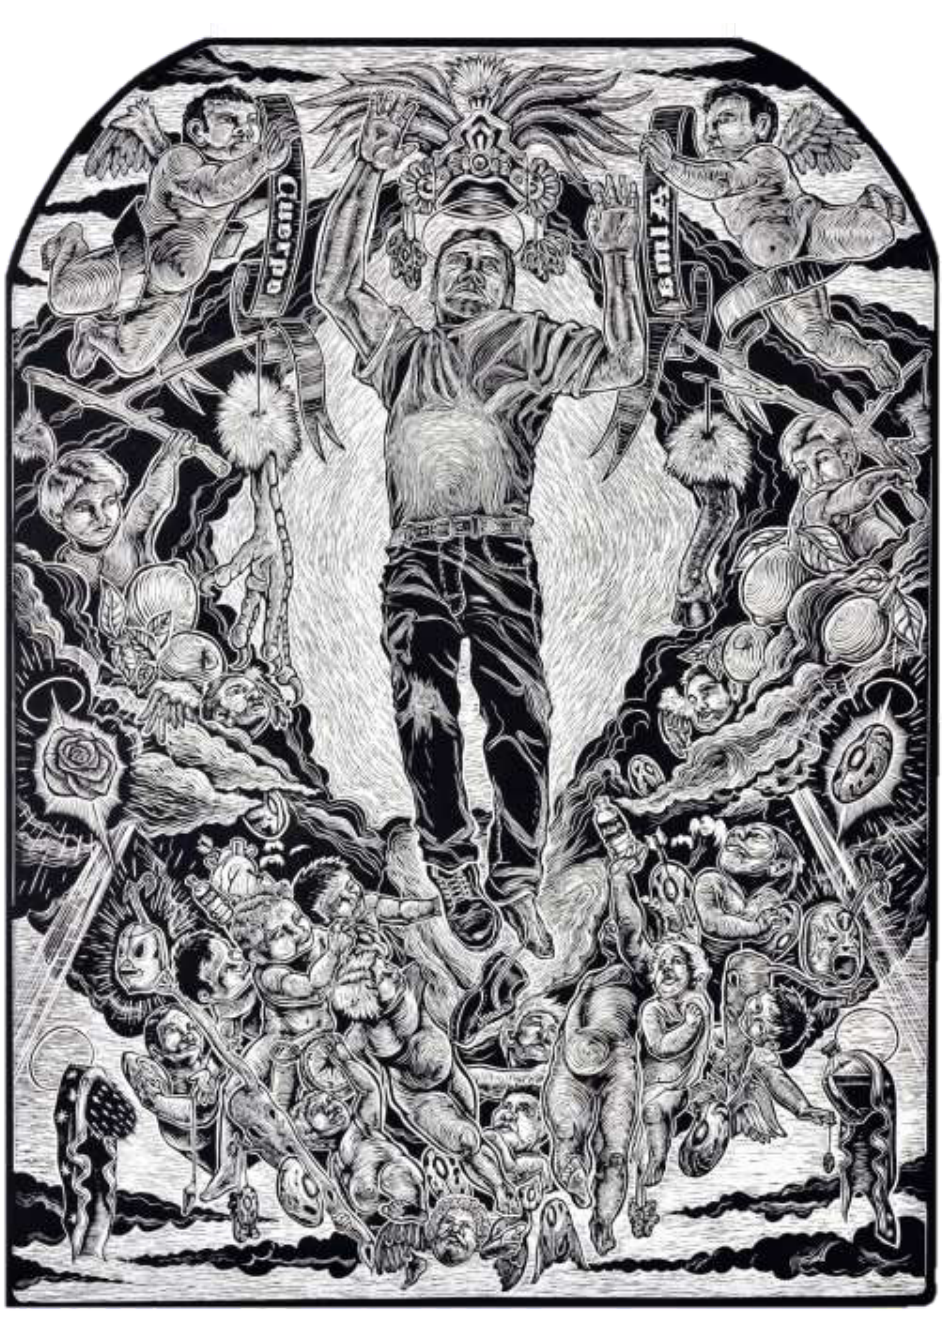
Juan de Dios Mora, Assumption of the Immigrant , 2009, linocut, 24 x 18 ⅛